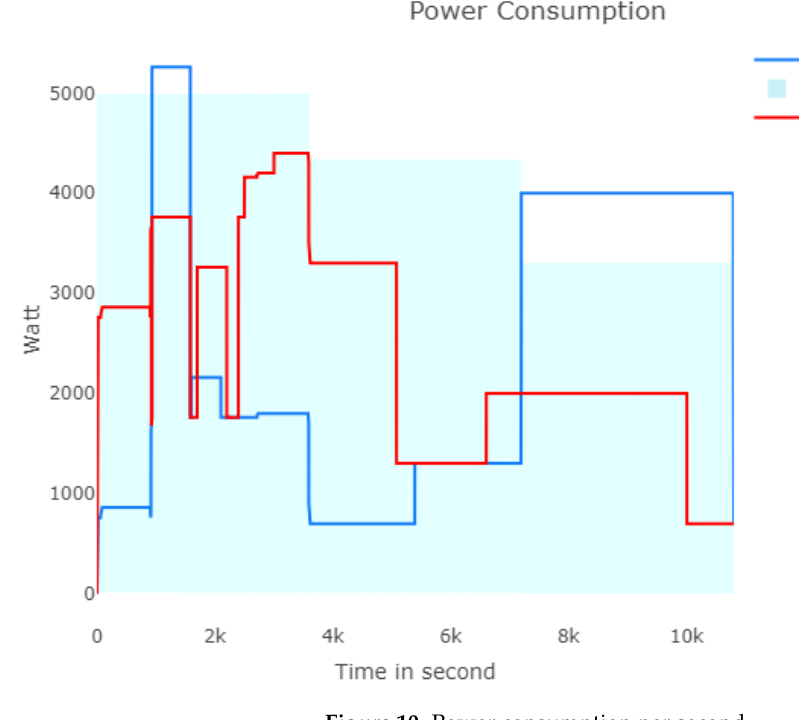
Figure 10. Power consumption per second.